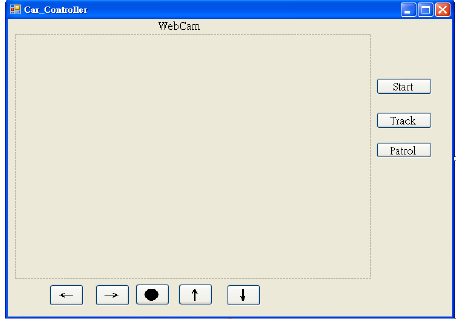
Figure 13. Visual studio 2008 operating interface.